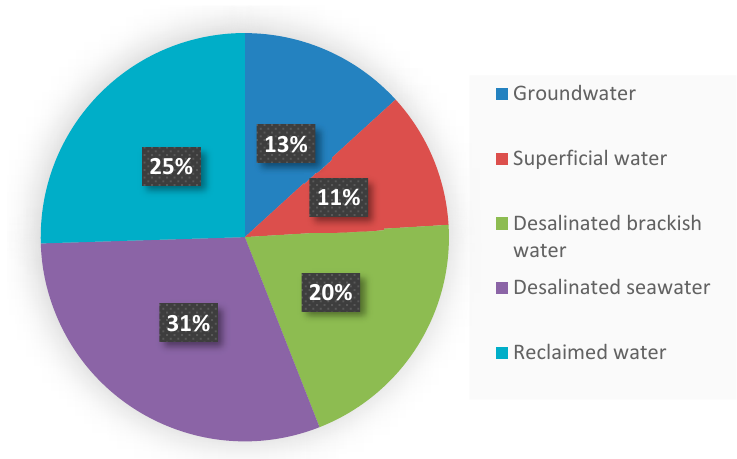
Figure 5. Typology of water resources used in the farms in the study area (% farms).